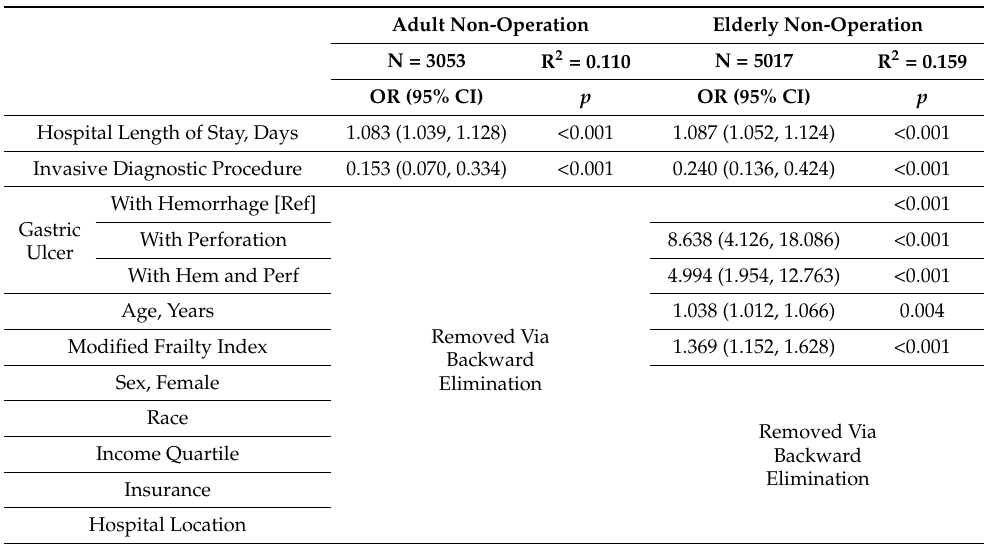
Table 6. The outcome of the backward logistic regression analysis to evaluate associations between mortality, which was the dependent variable, and various factors is presented in this table. The groups analyzed here were only those that elected to not have an operation/surgery. Data were supplied by NIS